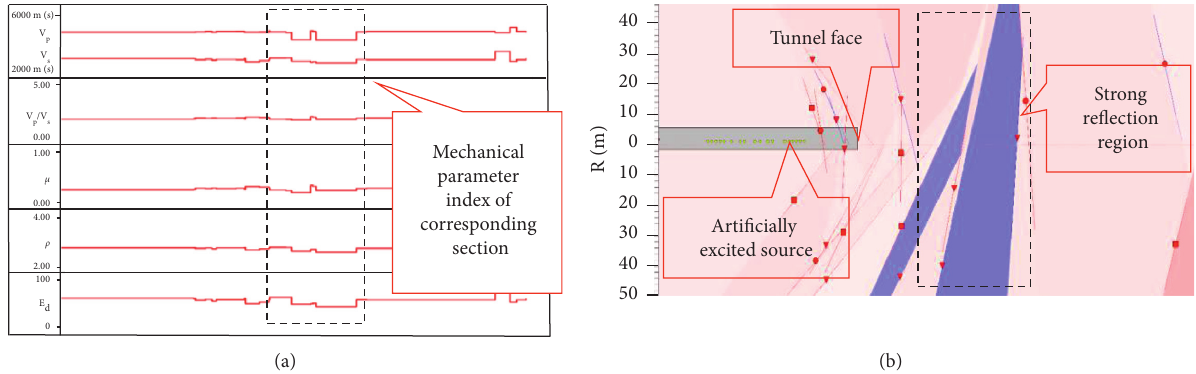
Figure 9: TSP advanced prediction interpretation. (a) TSP physical and mechanical parameters result map. (b) TSP reflective layer map.